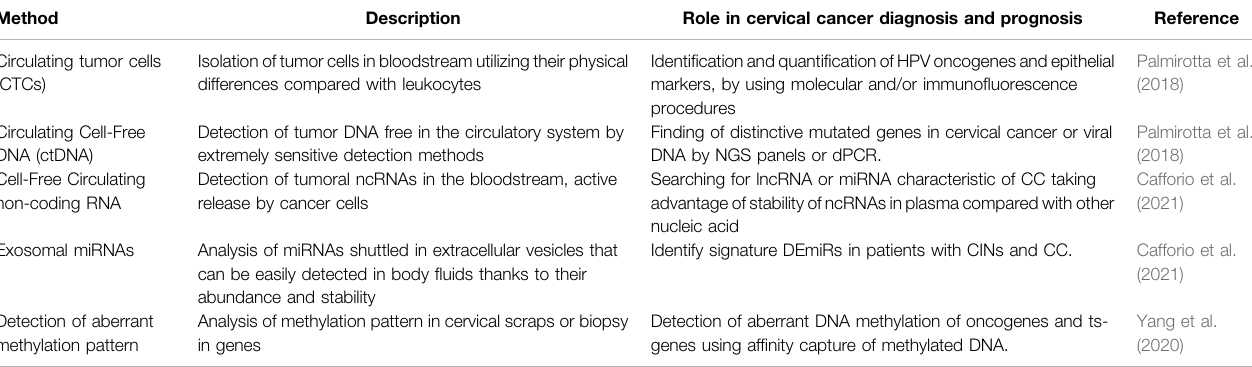
TABLE 3 | Molecular models for early cervical cancer diagnosis and